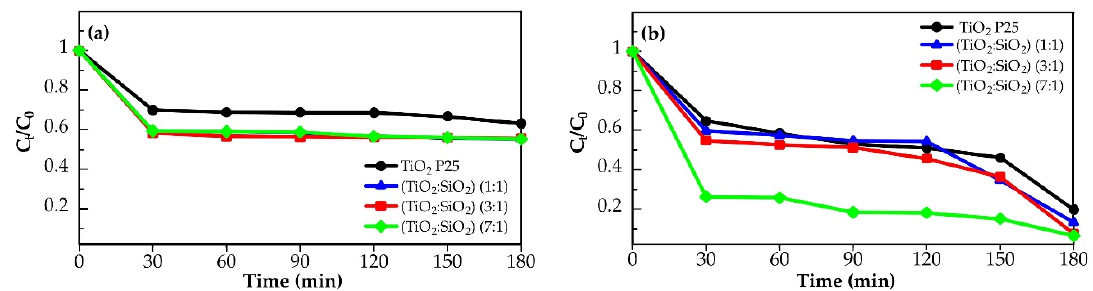
Figure 6. ( a ) Adsorption activity and; ( b ) photocatalytic activity of catalyst on Pb(II). The experiment was conducted using 100 mL Pb(II) ion solution 40 mg / L and 100 mg catalyst with 180 min treatment.